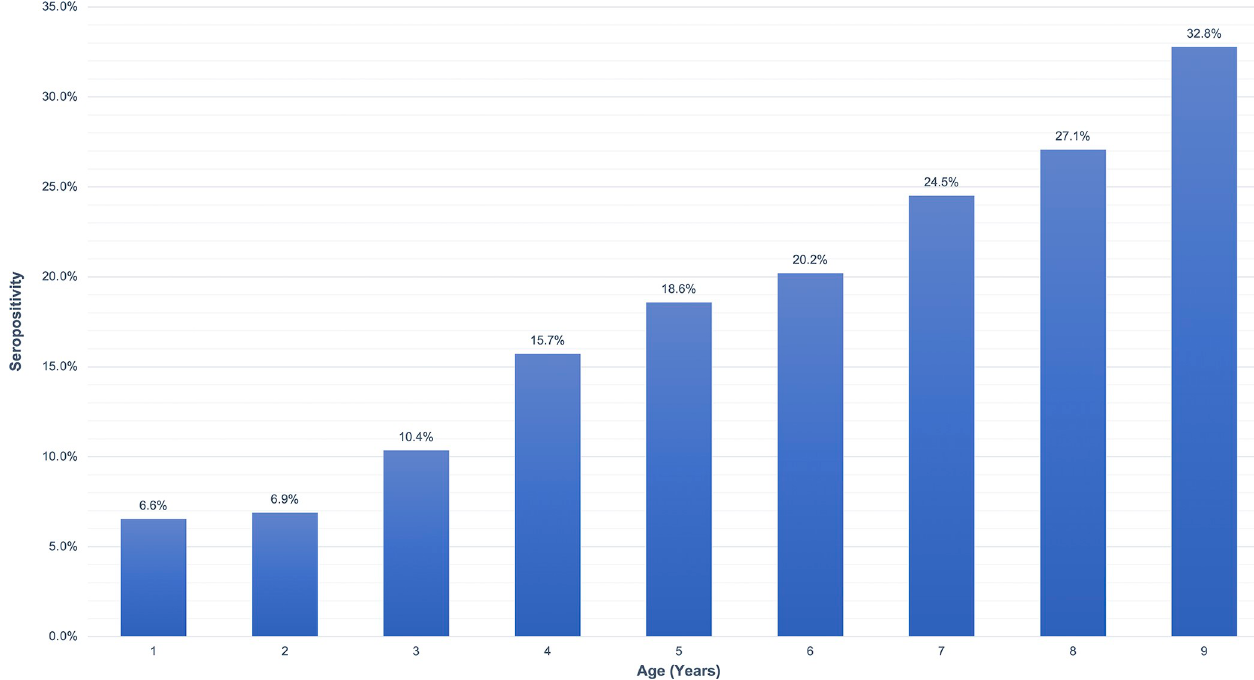
Fig 1. Seropositivity by age in children ages 1–9 years in Kongwa District, Tanzania.